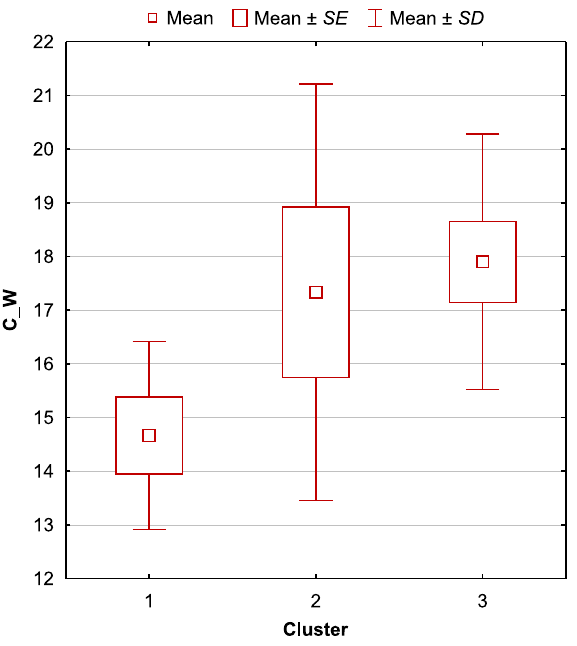
Figure 1. Clusters for the variable representing wom- en’s satisfaction with their partner in the context of physical activity (C_W). Cluster 1 = dominant – hos- tile women and more submissive – affiliative men; clus- ter 2 = women and men that are similar in the degree of dominance and affiliation; cluster 3 = submissive – af- filiative women and dominant – more hostile